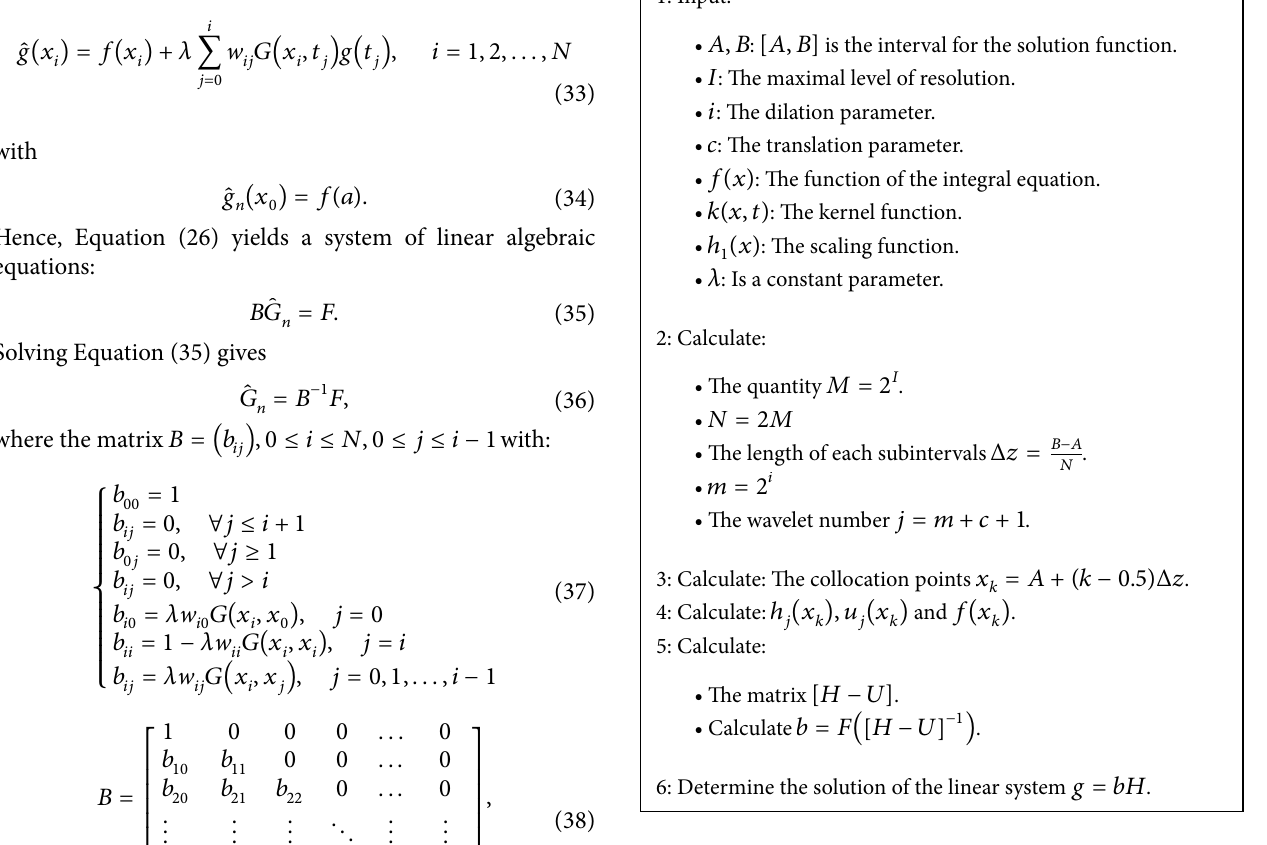
Algorithm 1: Numerical realization using the Haar wavelet